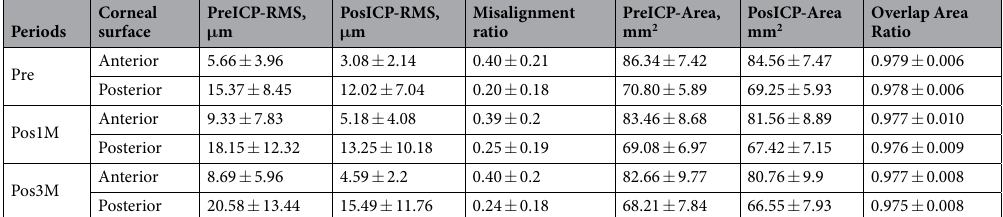
Table 2. Area and matching error results of the the first and second measurement. Pre means the period pre operation, Pos1M means 1 month post LASIK, Pos3M means 3 months post LASIK; PreICP-RMS and PosICP- RMS represent the root-mean-square error of the coordinate differences of corneal surface between two successive measurements before and after topography matching, respectively; Misalignment ratio = 1- PosICP-RMS/ PreICP-RMS; PreICP-Area, PosICP-Area represent the Overlap area of corneal surface between two successive measurements before and after topography matching, respectively; Overlap Area Ratio =